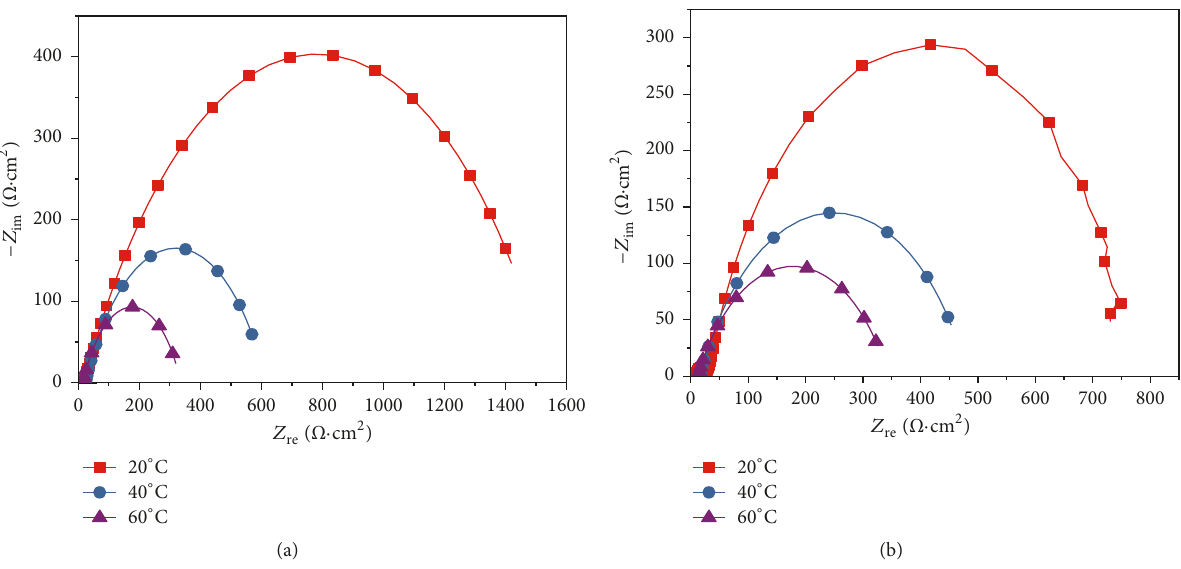
Figure 10: Influence of temperature on EIS profiles of (a) BM and (b) WM.